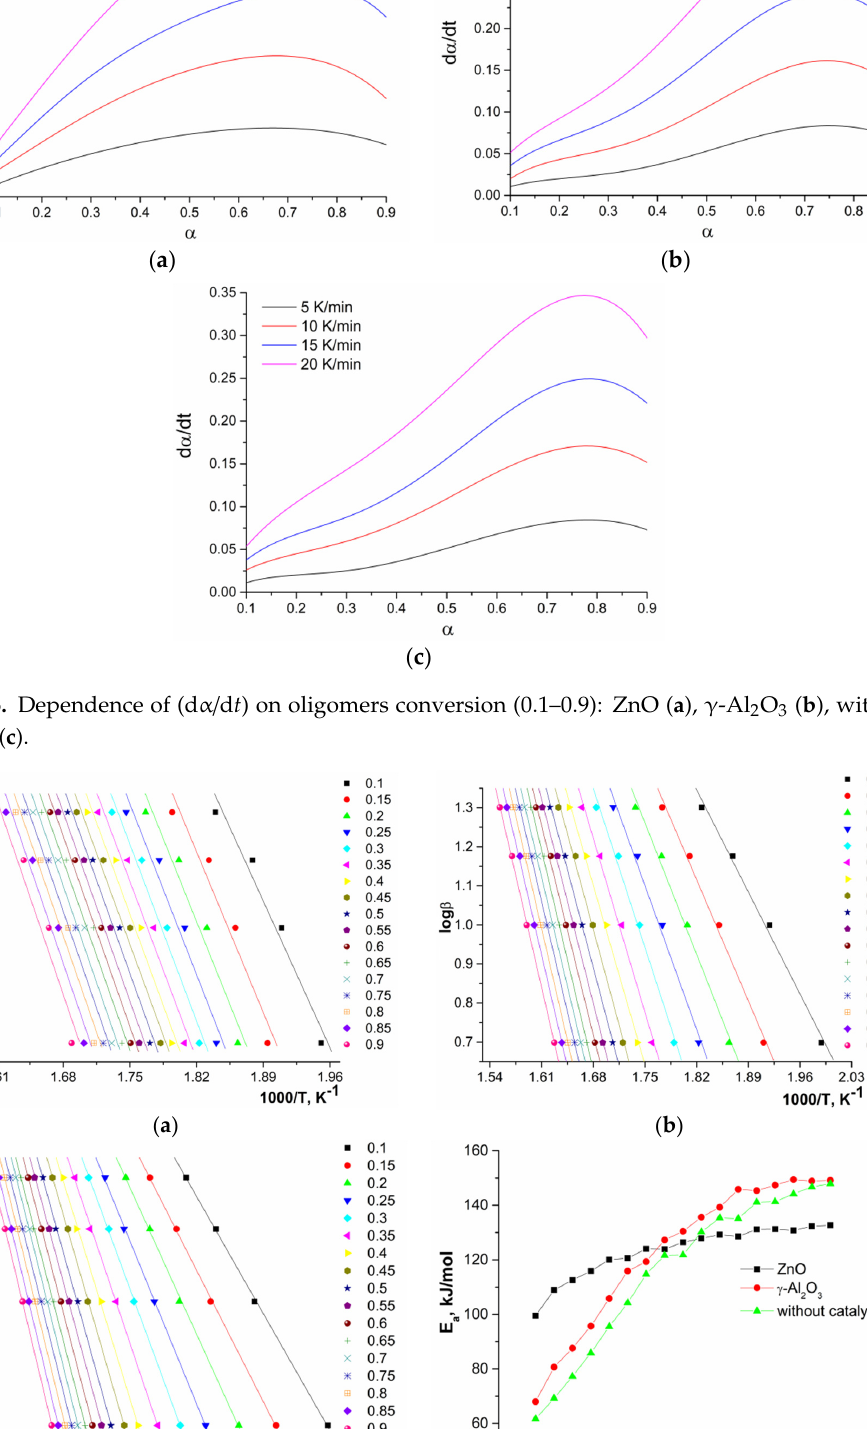
Figure 7. Dependences of log β on 1000 / T for depolymerization in the presence of ZnO ( a ), γ -Al 2 O 3 ( b ),